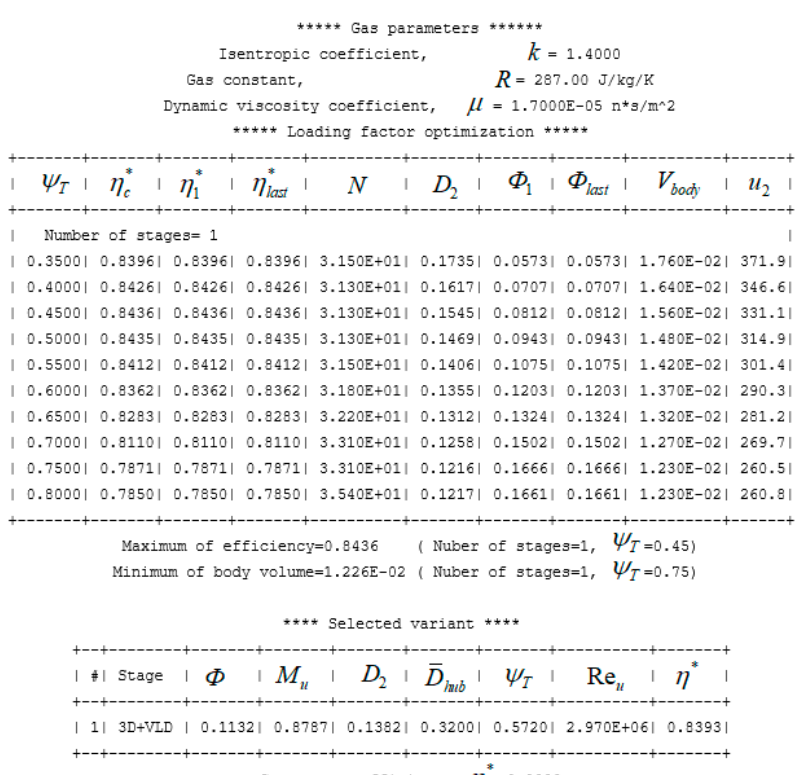
Figure 3. CCPC-G9E program. Characteristics of the TKR 140E compressor with a flow path according to the primary design.